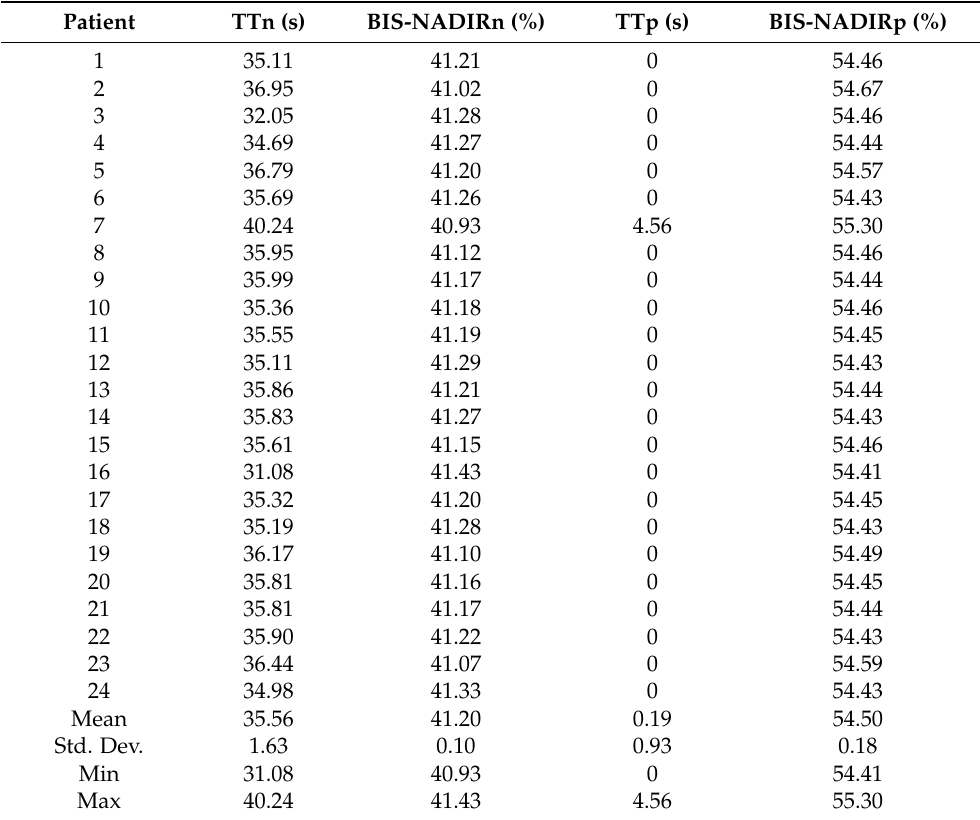
Table 6. Final disturbance rejection performances for each